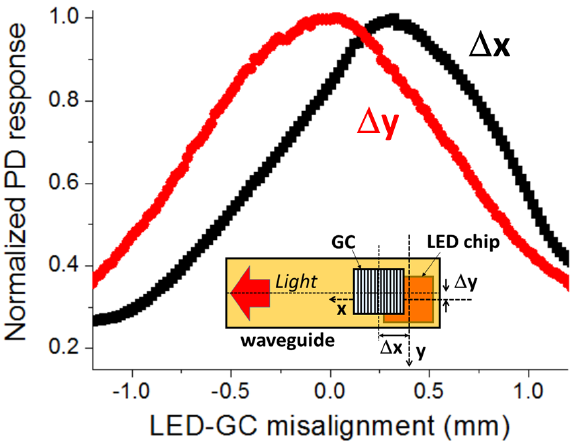
Figure 4. Normalized power detected by the photodetector (PD) as a function of the misalignment between the LED chip and the grating coupler (GC) along the x-axis and y-axis. ∆ x ( ∆ y) equals the LED chip center position minus the GC center position along the x-axis (y-axis) according to the inset diagram. Guided light propagation direction is +x-axis.